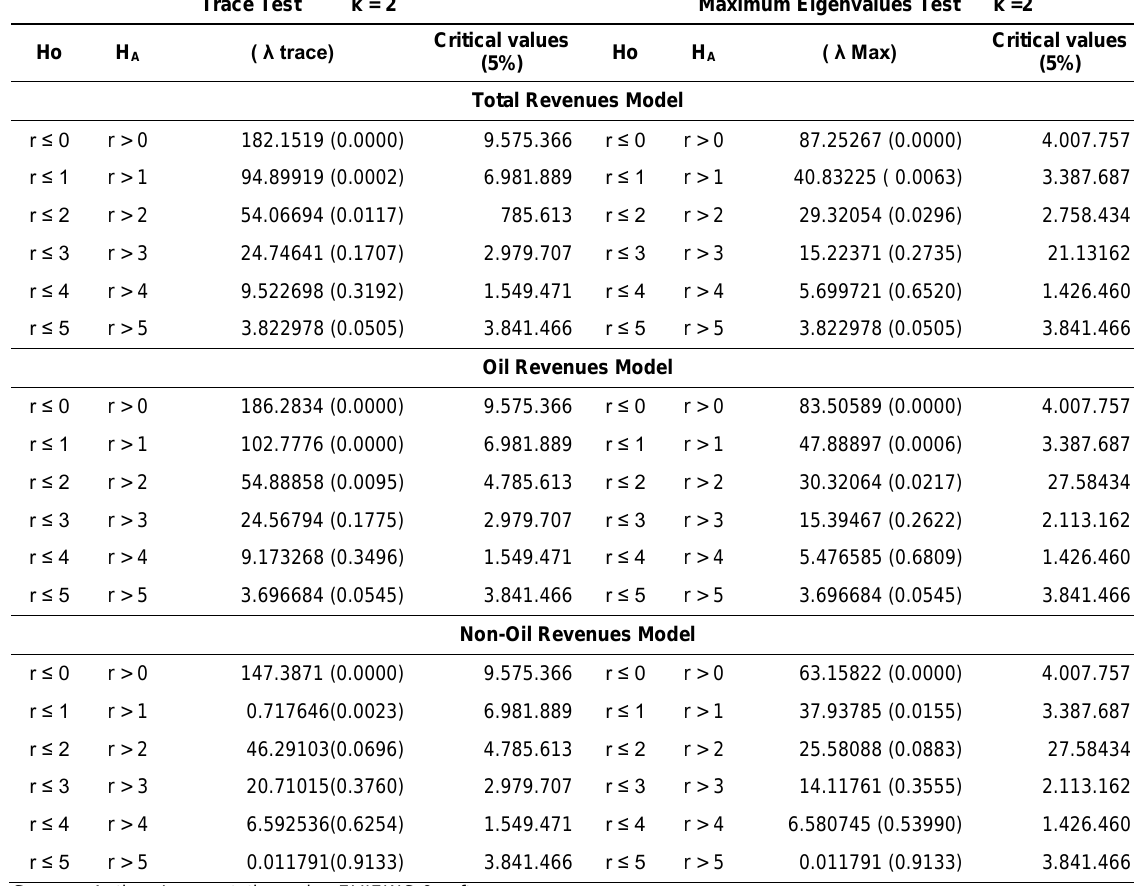
Table 3 . Johansen Cointegration Test